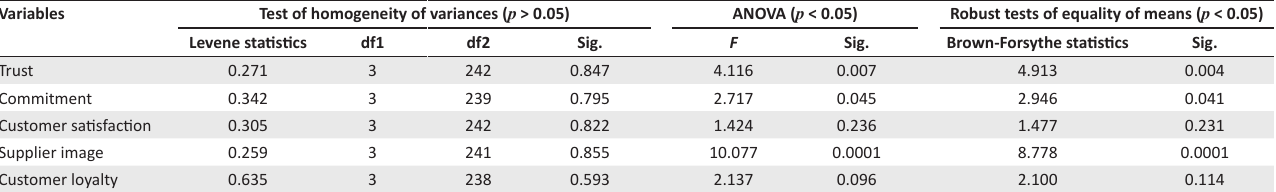
TABLE 6: Test of homogeneity of variance, ANOVA and Robust Tests of Equality of Means, based on different racial groups. Variables Test of homogeneity of variances ( p > 0.05) ANOVA ( p <